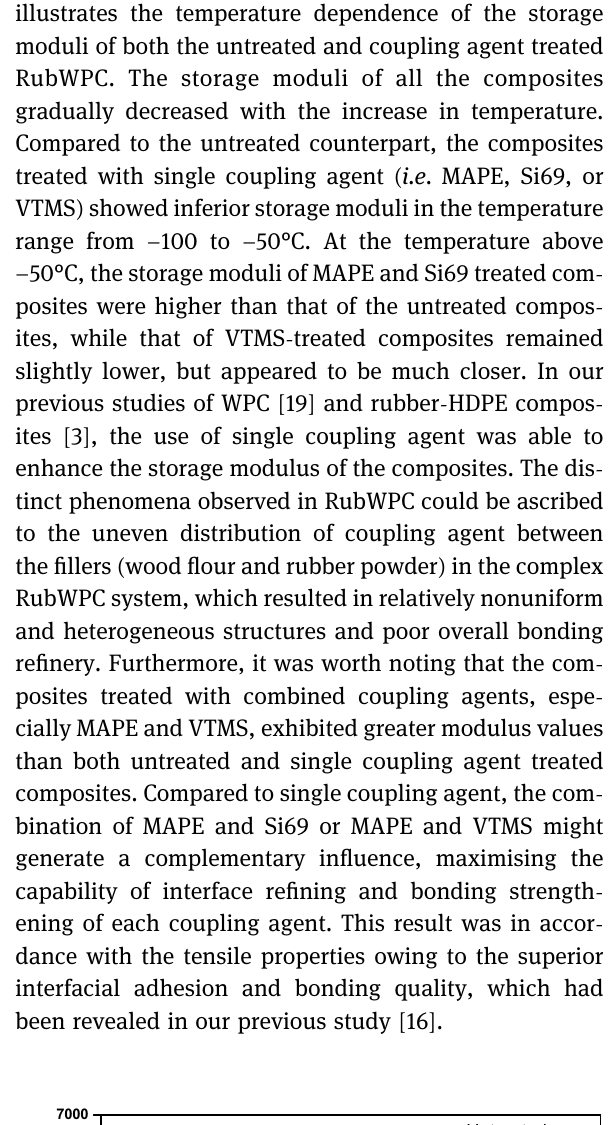
( Figure 2b and c ) . The indentations were conducted under load - controlled mode consisting of three segments, i.e. loading with 150 µN in 5 s, holding for 2 s, and unloading in 5 s. A typical loading - displacement curve is presented in , the maximum depth Figure 3. The maximum load P max , the fi nal depth after unloading h , and the slope of h max r the upper portion of the unloading curve S were monitored in a full loading - unloading cycle. The material properties, such as reduced elastic modulus and hardness, could be extracted by analysing the data with the method developed by Oliver and Pharr [ 18 ] .